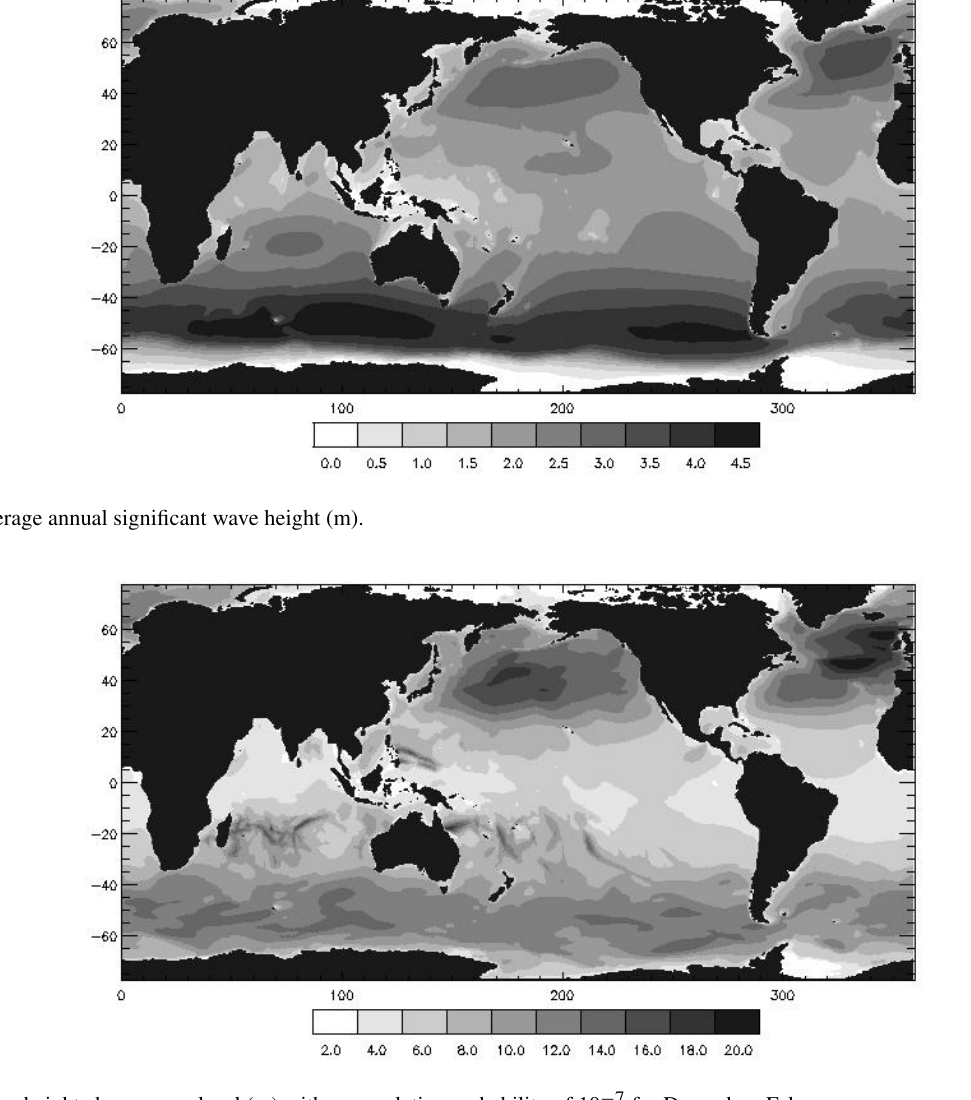
Figure 3. Wave height above mean level (m) with a cumulative probability of 10 − 7 for